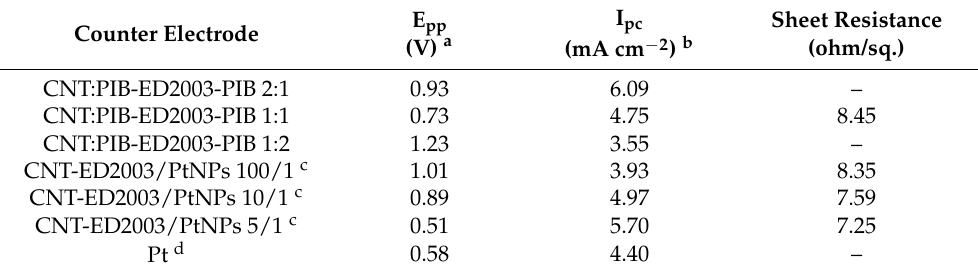
Table 1. CV analysis table of CNT/PIB-ED2003-PIB at different weight